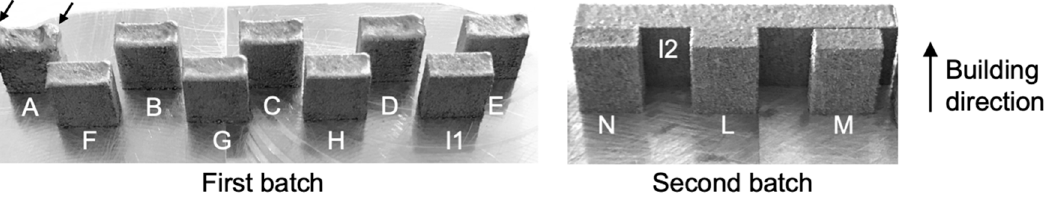
Figure 3. Photographs of parallelepiped samples before removal from support; arrows indicate accumulated material at corners of upper surface in sample A.